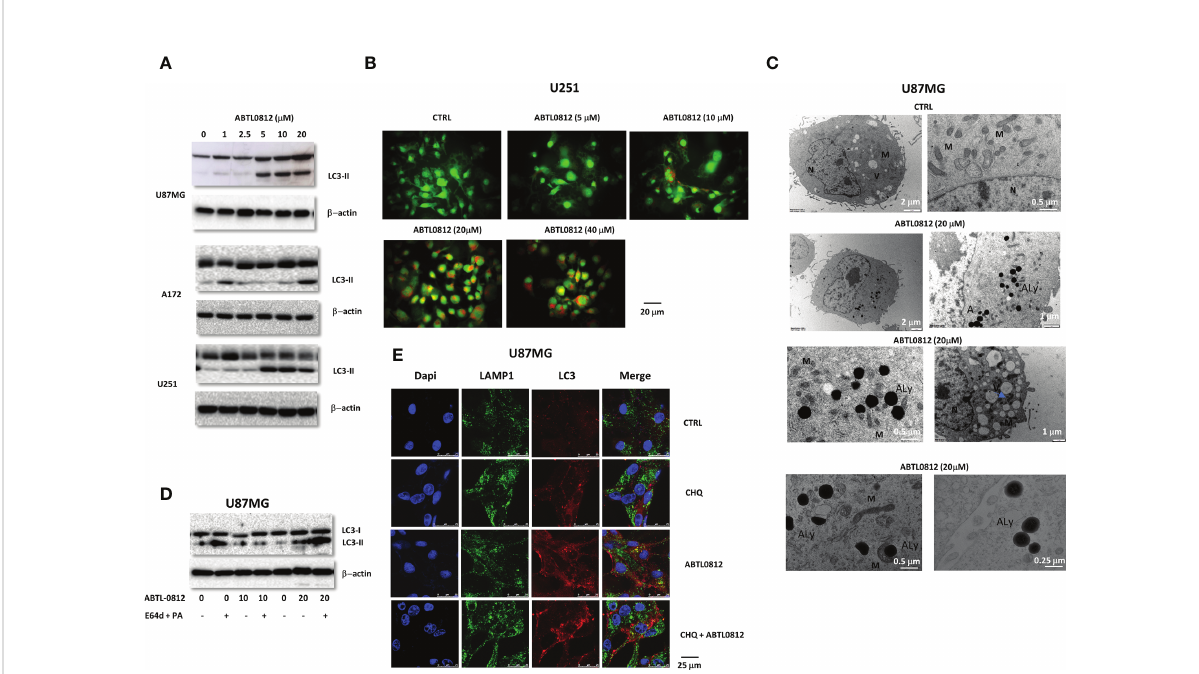
FIGURE 3 ABTL0812 induces autophagy in glioblastoma cells. (A) Representative immunoblotting images of LC3-II from U87MG, A172 and U251 cell lines treated with ABTL0812 for 12 hours. (B) Representative immuno fl uorescence images of staining with acridine orange, a green fl uorophore that fl uoresces red in acidic vesicular organelles (AVO) in U87MG cells treated for 12 hours with ABTL0812 (40X magni fi cation). (C) Representative electron microscopy microphotographs of U87MG in cells treated with ABTL0812 at 20 and 40 m M for 12 hours. N= nucleus, Au=autophagosomes; M= mitochondria and V= vesicles. Blue arrows indicate small or unfunctional mitochondria. (D) Representative immunoblotting images of LC3-II from U87MG cells pretreated with lysosome protease inhibitors (E64 and pepstatin A at 10 mg/ml each) for 24 hours followed by 12 hours treatment with ABTL0812. (E) Representative immuno fl uorescence images of the staining of LAMP1 and LC3 in U87MG cells treated with ABTL0812 (20 m M) for 12 hours with or without a pretreatment of 1 hour with chloroquine (3 m M). LAMP1 in is a marker of endosomes/lysosomes (green signal), LC3 is a marker of autophagosomes (red signal) and DAPI stains nuclei (blue signal). The colocalization of red and green signal results in orange signal and corresponds to autolysosomes. CTRL, control vehicle-treated